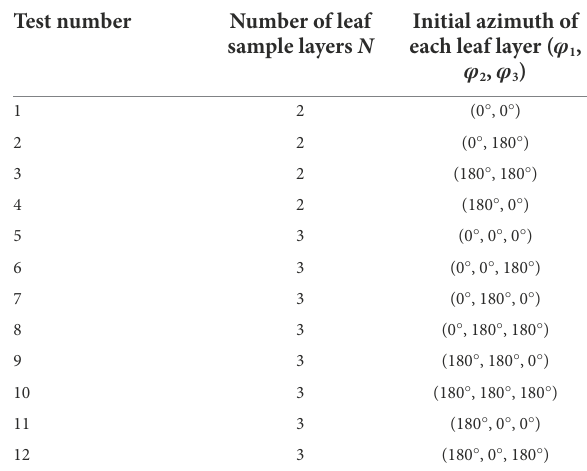
TABLE 4 Test scheme of airflow resistance characteristics for multi- position attitude of multi-layer